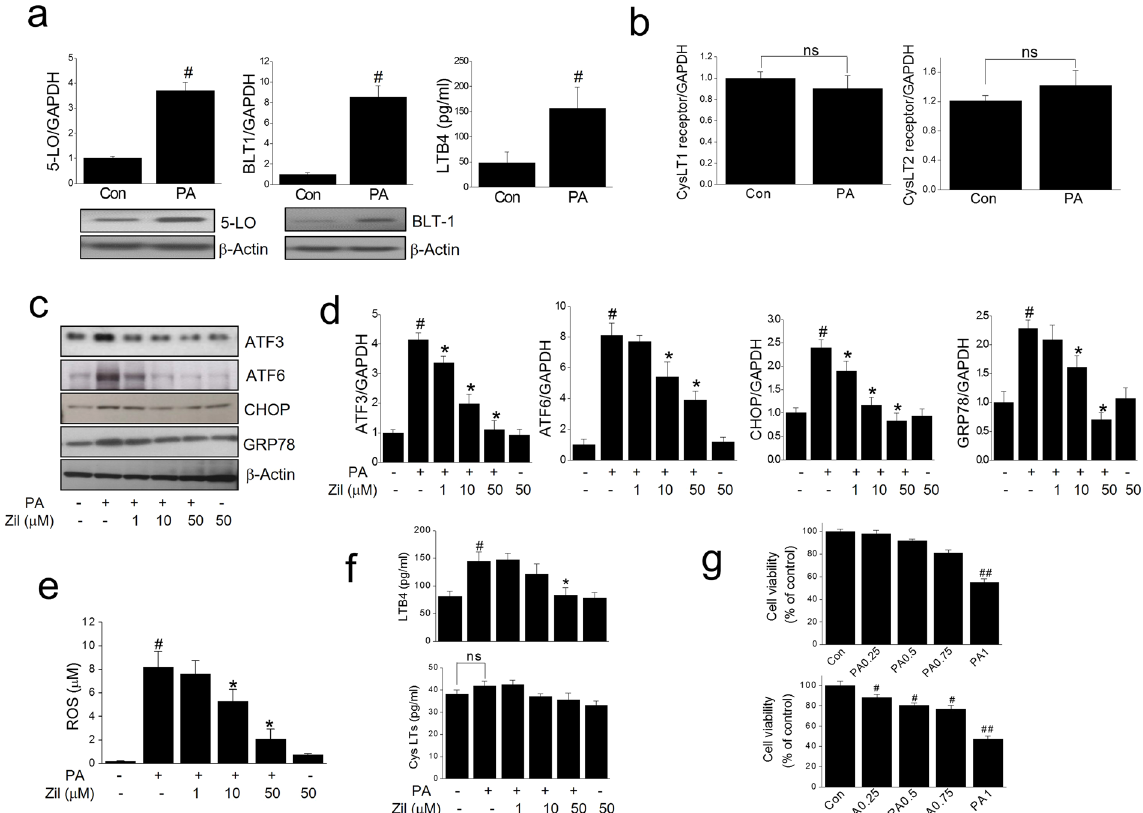
Figure 1. Effects of zileuton on PA-induced ER stress and oxidative stress. The mRNA expressions of 5-LO, BLT1, CysLT1 and CysLT2 in C2C12 myotubes were determined by qPCR with or without PA treatment (750 μ M for 12 h) ( a , upper). 5-LO and BLT1 protein levels were determined by western blotting with or without PA treatment ( a , lower). LTB4 production was determined by LTB4 kits, with or without PA treatment (750 μ M for 24 h) ( a ). The mRNA expressions of CysLT1 and 2 receptors were determined by qPCR with or without PA treatment ( b ). C2C12 myotubes were pre-exposed to different concentrations of zileuton (1-50 μ M) for 1 h and then treated with PA (750 μ M) in the presence of zileuton for 12 h (qPCR) or 24 h (western blot, LTB4/ CysLTs ELISA and ROS). The expression levels of ER stress markers were then determined by western blotting ( c ) and qPCR ( d ). ROS production was assessed using AmplexRed ( e ), and LTB4 and CysLTs production was determined by LTB4 and CysLTs ELISA kits, respectively ( f ). Cell viability was determined after 24 h PA treatment by MTT assay ( g , upper) and LDH release measurement ( g , lower). The results of the western blotting are shown as the representative of three independent experiments ( a and c ), and other results are expressed as the means ± SDs of three experiments performed in triplicate. # P < 0.05, ## P < 0.01 vs . non-treated controls, * P < 0.05 vs . PA alone. ns; not